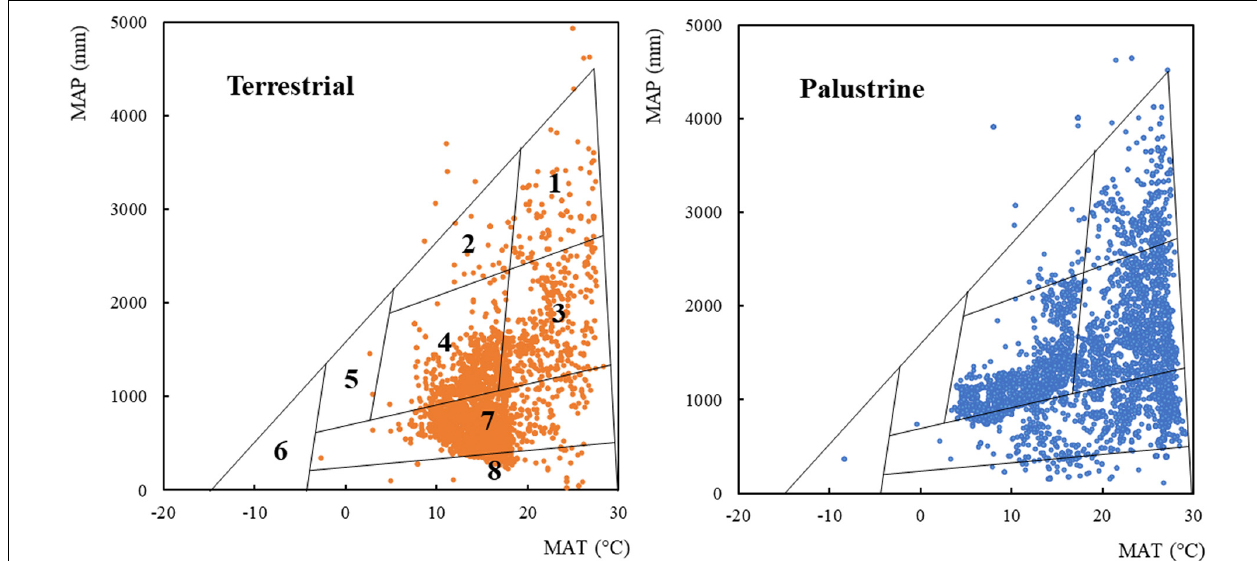
FIGURE 1 | The boundaries of global biome type in relation to the climate factors mean annual temperature (MAT) and mean annual precipitation (MAP; Whittaker, 1970; Wright et al., 2004). For each habitat (terrestrial and palustrine), 5250 plant records (randomly selected and equalized, see section “Materials and Methods”) are overlaid on the climate envelopes of Whittaker’s biomes. Terrestrial and palustrine records are represented as brown and blue dots, respectively. (1) Tropical rainforest; (2) temperate rainforest; (3) tropical seasonal forest; (4) temperate forest; (5) boreal forest; (6) tundra; (7) woodland, shrubland, and grassland; (8) desert. Biome boundaries are only approximate. Specific abundances in each type of biome can be found in Supplementary Table 1 .